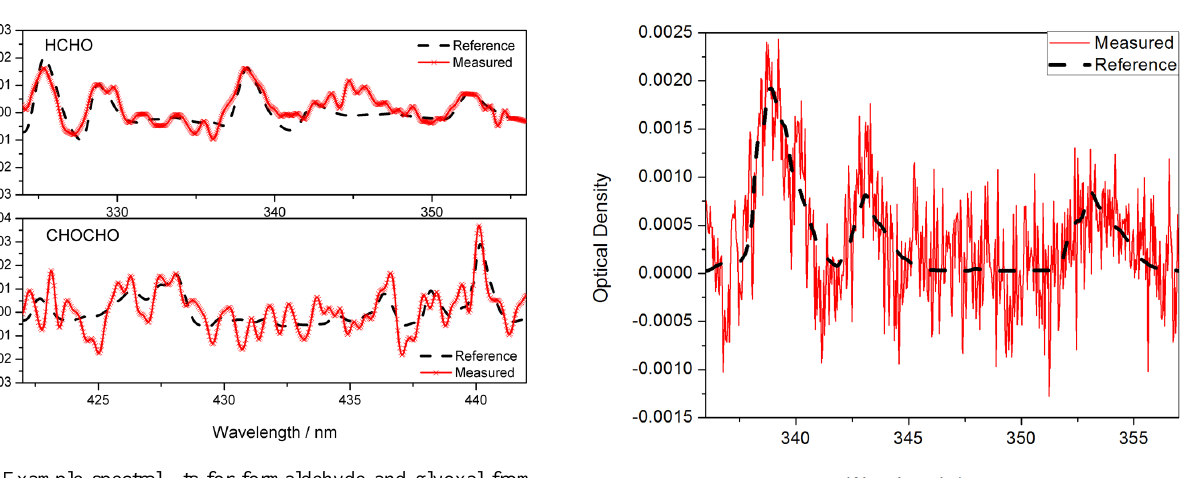
Fig. 3. Example spectral fits for formaldehyde and glyoxal from the LP-DOAS analysis. The red solid lines and markers show the measured atmospheric spectrum after all other absorbers have been subtracted and the dashed lines show the respective reference spec- tra for HCHO and CHOCHO, corresponding to 2452 ± 74ppt and 764 ± 72ppt, respectively.